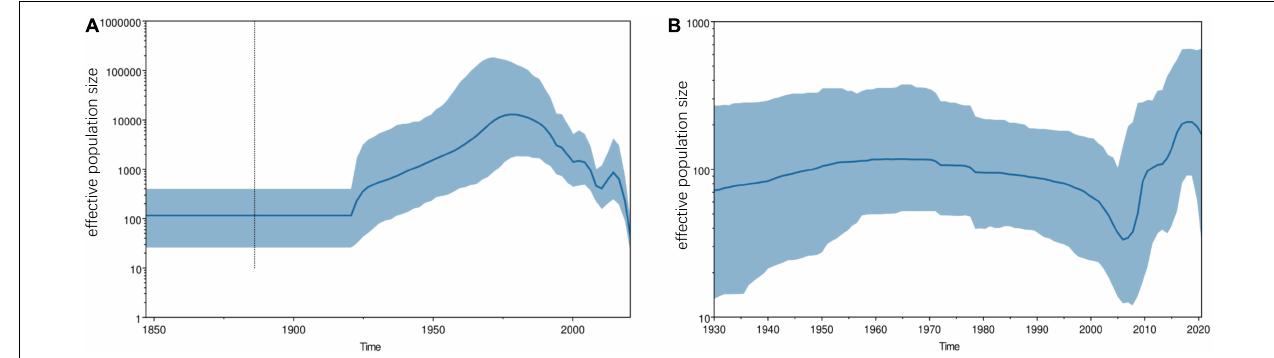
FIGURE 6 | Demographic history of FCoV-I (A) and CCoV-IIa (B) . Plots show the effective population size (y-axis) through time (x-axis). The blue lines indicate the median estimates of effective population size, and the shaded regions indicate the corresponding 95% confidence interval. (A) FCoV-I demographic history